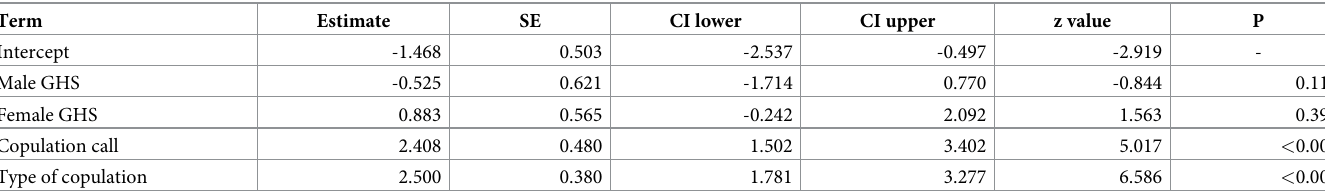
Table 3. Female post-copulatory darting model. Binomial GLMM evaluating if the likelihood of female darting was influenced by the male and female GHS, presence of copulation calls, and type of copulation (ejaculatory vs non-ejaculatory). Term Estimate SE CI lower P Intercept - Male GHS Copulation call < 0.001 Type of copulation < 0.001 Estimates, standard errors (SE), z-values, and 2.5% and 97.5% confidence intervals (CI) are shown for fixed effects. Intercept with reference category is shown for ulcerated individuals, presence of copulation calls, and ejaculatory